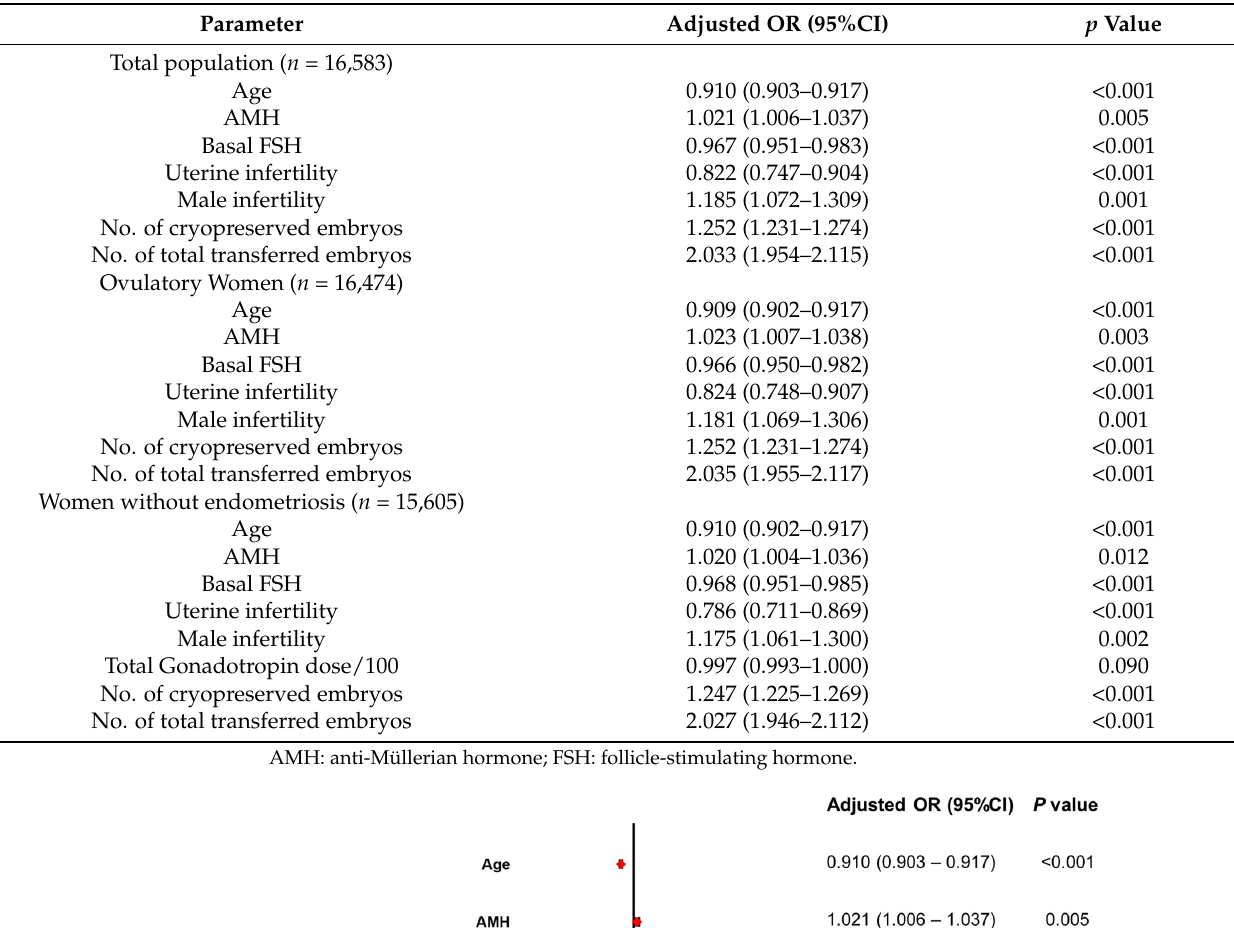
Table 2. Multiple logistic regression analysis.